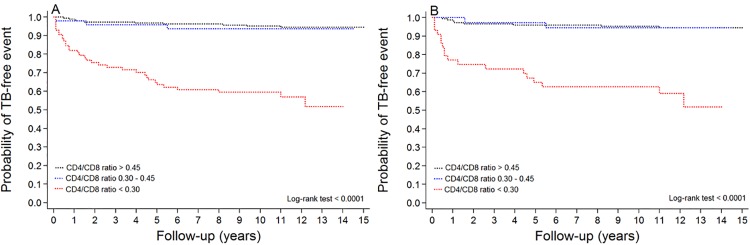
Kaplan-Meier estimates for incident TB in patients on antiretroviral therapy.Time-updated CD4/CD8 ratio in all cases (A), and in those with virological suppression.